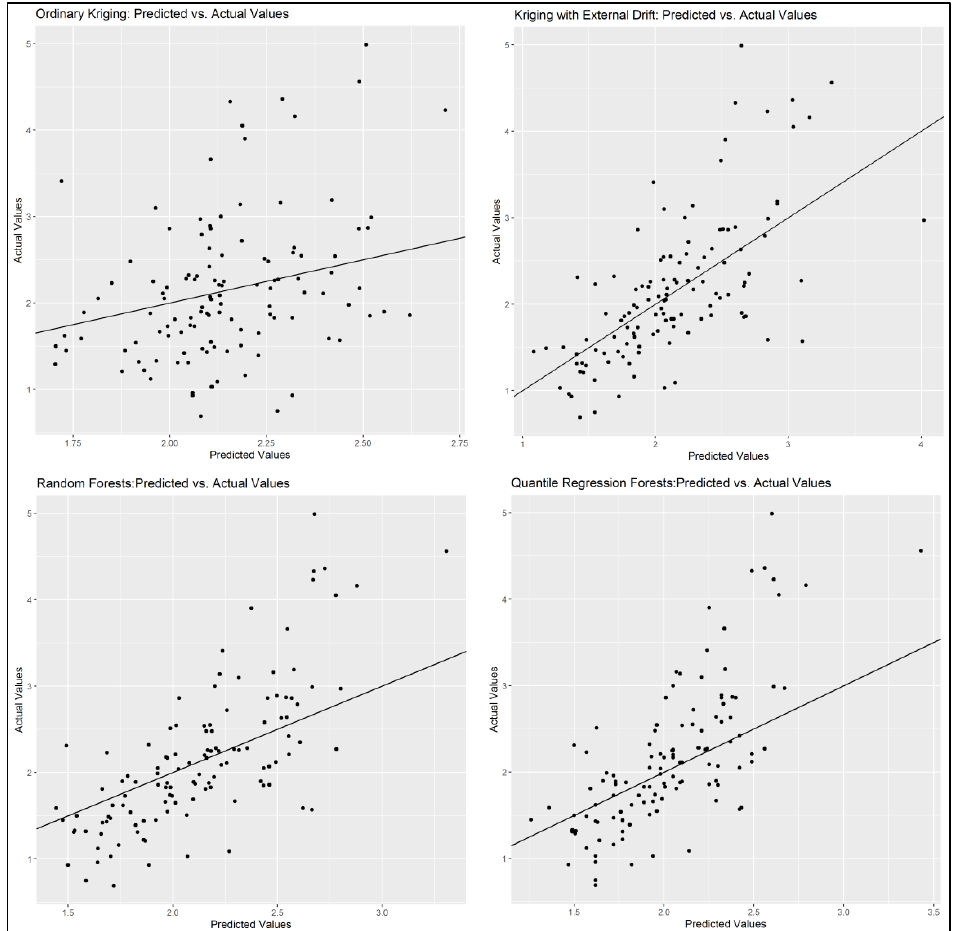
Figure 9. Predicted vs observed scatter